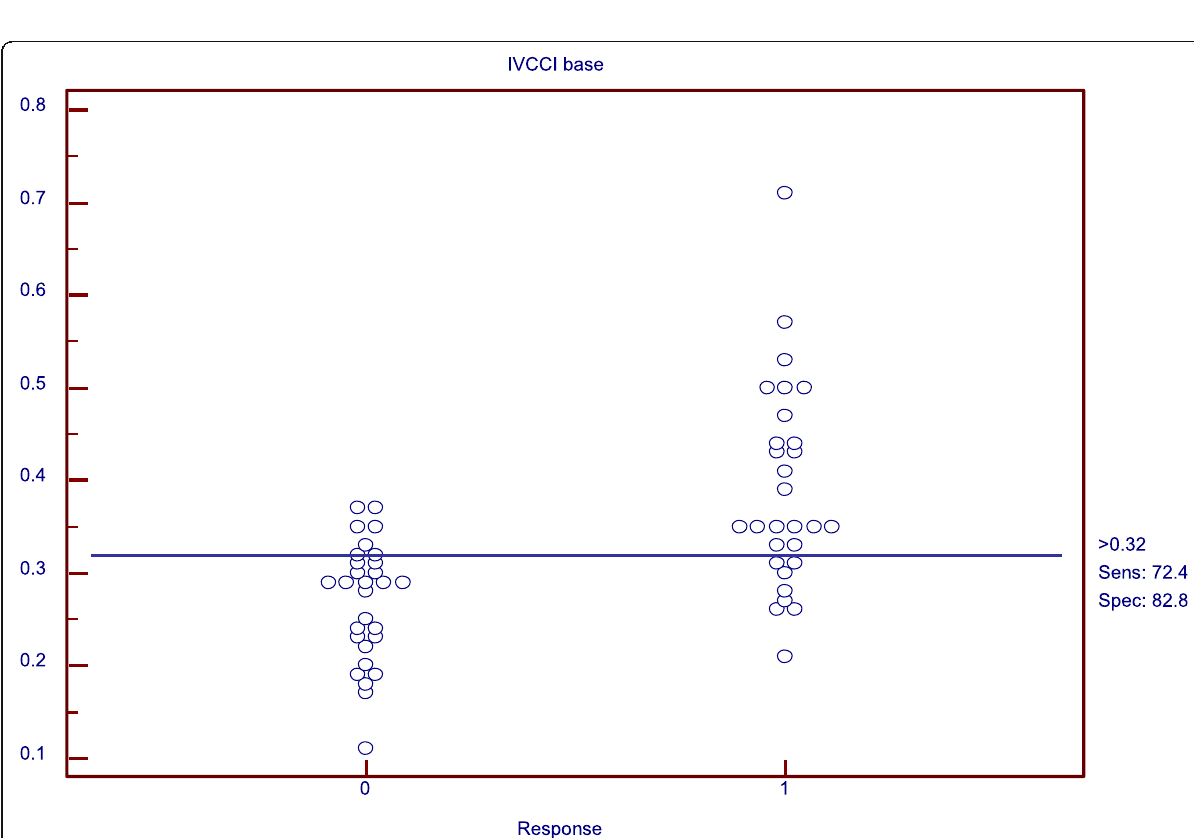
Fig. 2 Sensitivity and specificity demonstration using scatter plots. Inferior vena cava collapsibility index at baseline in non-responders (0) and responders (1). Individual values expressed as the small